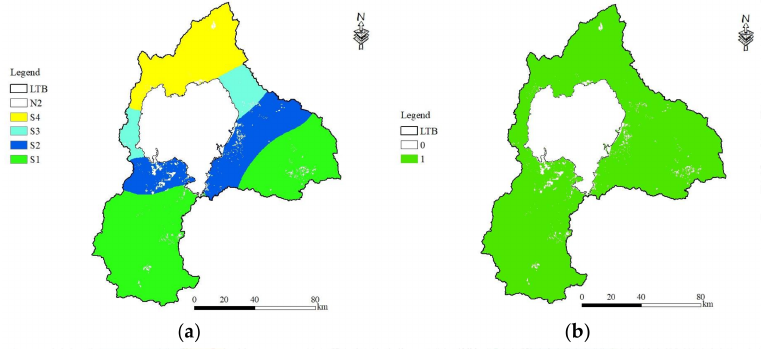
Figure 10. ( a ) Rainfall deficit suitability class; and ( b )